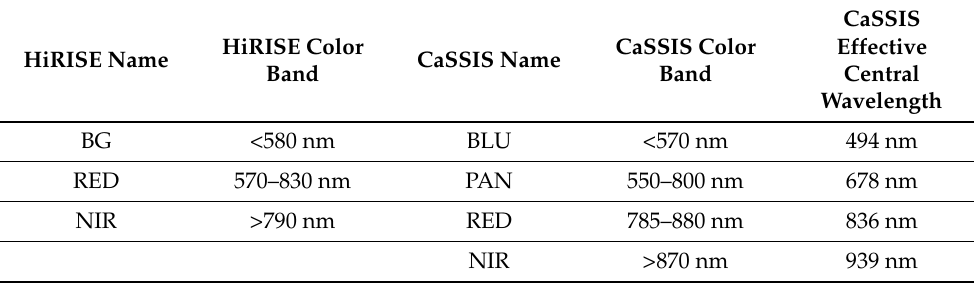
Table A2. A comparison of the HiRISE and CaSSIS filter bandpasses. HiRISE data taken from McEwen et al. [1]. The filters are not perfect top-hat functions and cut-off values can be +/ − 5 nm depending on the definition